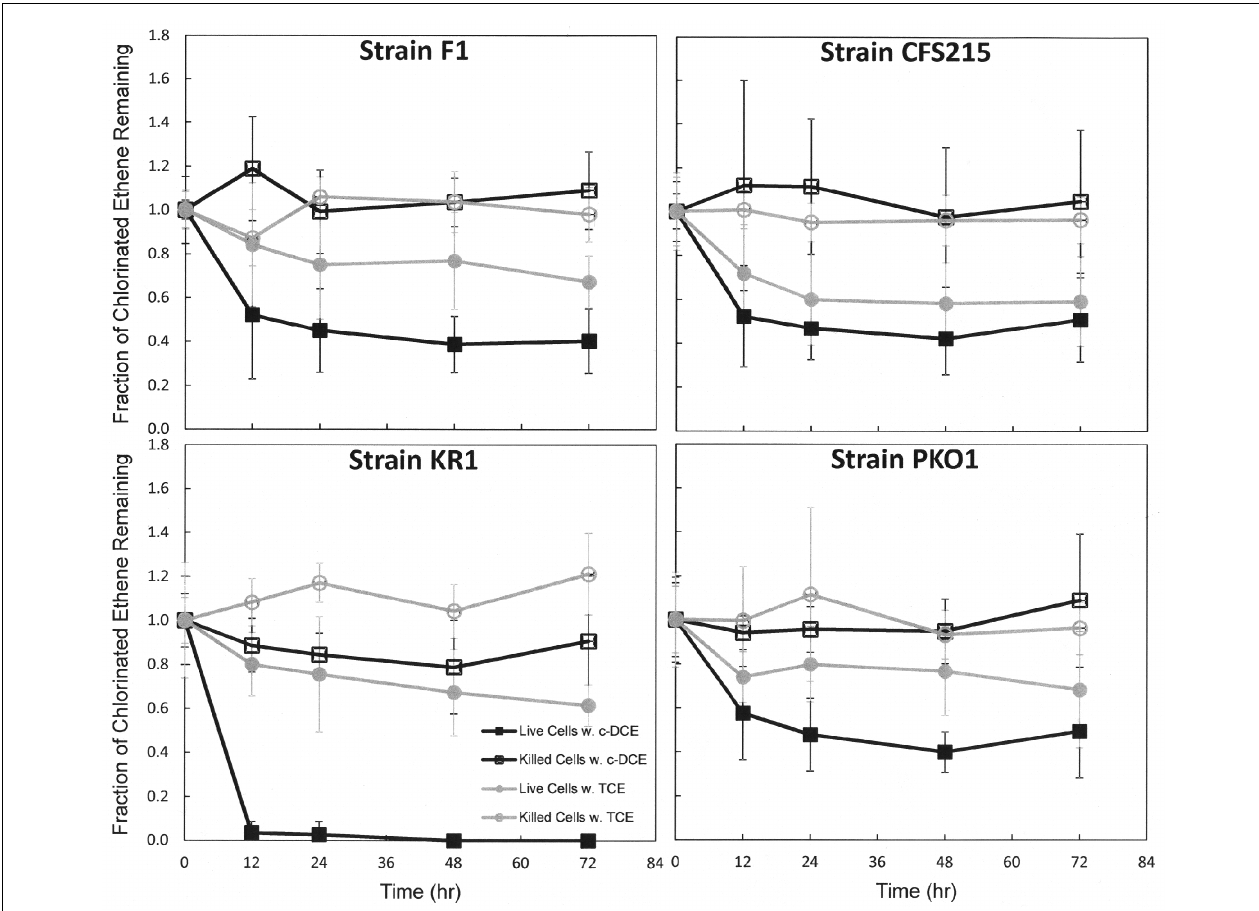
FIGURE 1 | Degradation curves of cis -1,2-dichloroethene (c-DCE) and trichloroethene (TCE) by four bacterial strains: Pseudomonas putida F1,